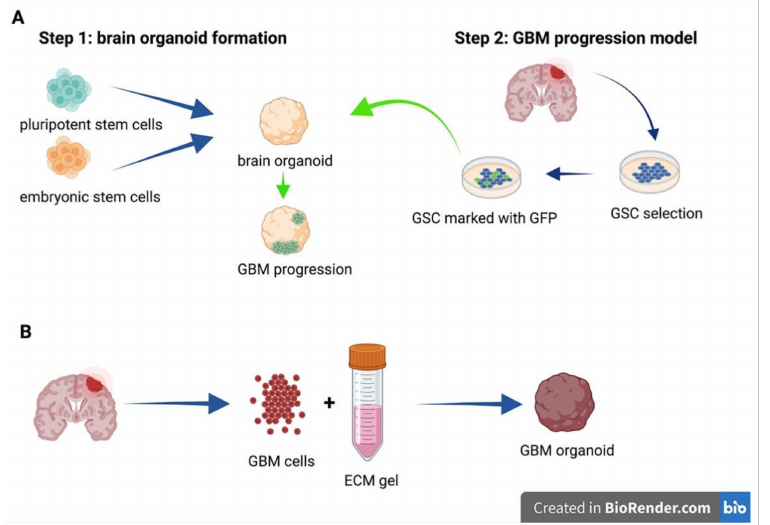
Figure 2. Examples of GBM organoid use in research. ( A ): GSC obtained from a patient are transfected with green fluorescent protein (GFP) and co-cultured with brain organoids, obtained from pluripotent or embryonic stem cells, to study tumor progression. ( B ): GBM organoids are obtained from GBM cells dissociated and grown in Matrigel